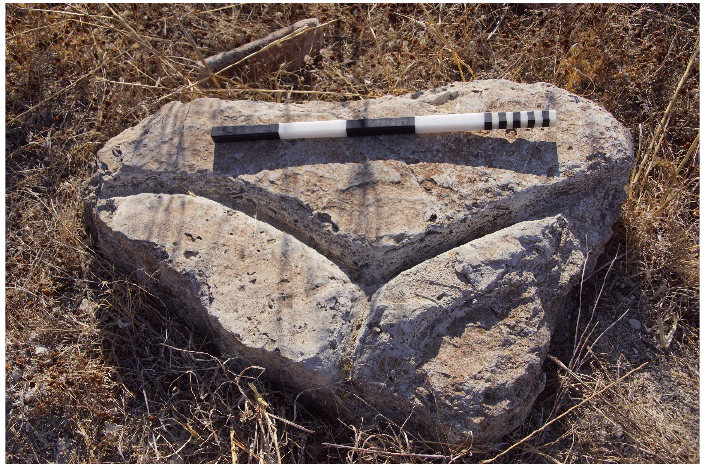
Figure 26. A probable olive press found in a Late Antique hamlet-site in the Xeros River valley (Image by Athanasios K. Vionis).